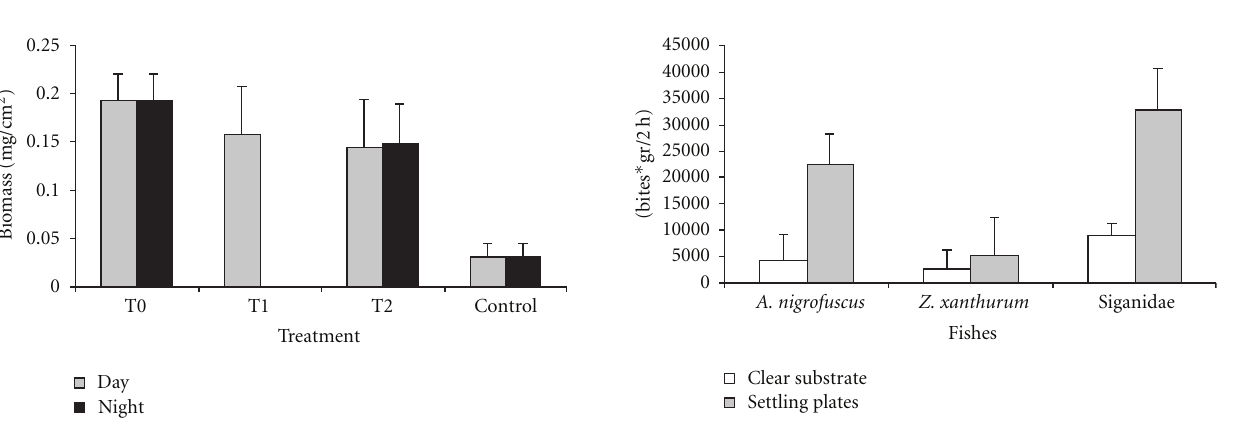
Figure 5: Bite rate (bites ∗ gr/2hr), of each recorded species, on settlement plates ( n = 6) and on clear substrate ( n = 4), during a 2-hour exposure period, in August 2008.